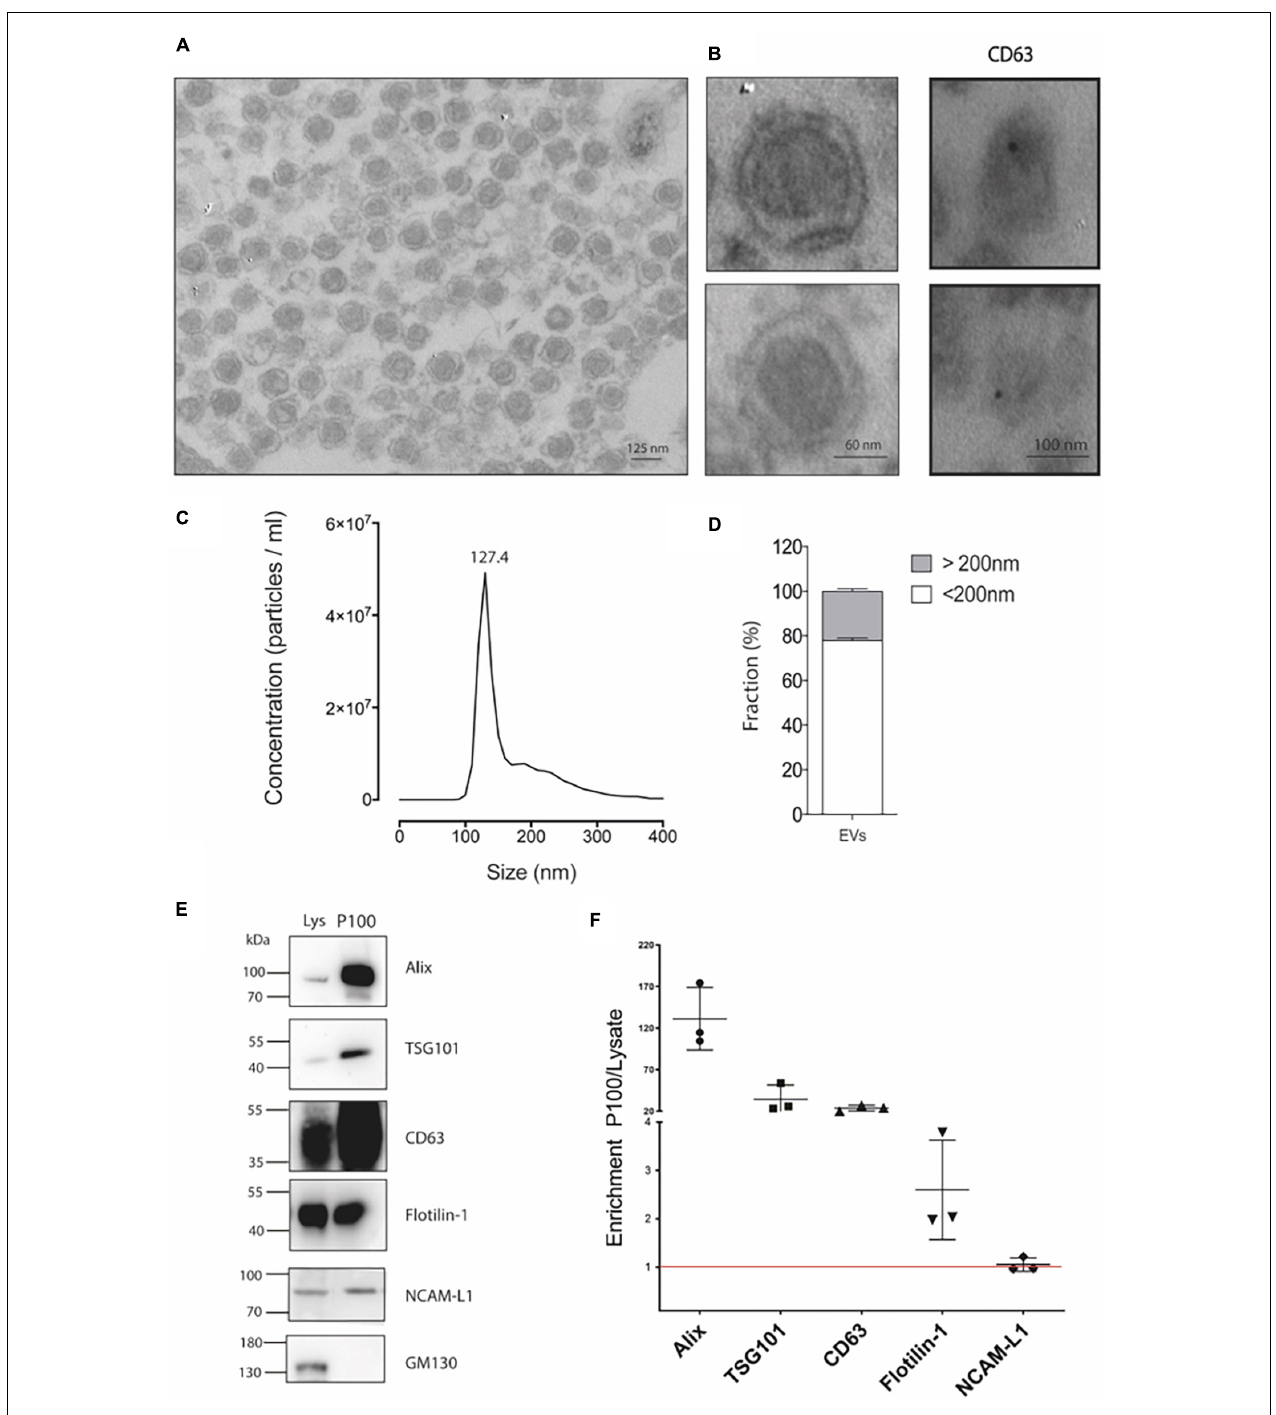
FIGURE 1 | Detailed characterization of P100 vesicles secreted from hippocampal HT-22 cells. (A) Representative transmission electron microscopy of P100 shows abundant vesicles with exosome-like appearance with an average diameter of 124.1 ± 6.8 nm of ( n = 31; three independent cell culture preparations). (B) Close capture of single exosomes (left) and immunogold labeling of a selective exosomal biomarker, CD63 (right panel, black dot). (C) Nanoparticle tracking analyses show a mean peak at 127.4 ± 1.3 nm ( n = 5; five independent cell culture preparations). (D) Abundance analysis shows that 77.88 ± 2.41% of the vesicles have a diameter of < 200 nm and a 22.12 ± 2.41% > 200 nm ( n = 4; four-five independent cell culture preparations). (E,F) Western blot and Analysis enrichment (fold) of the protein content of the exosomal markers Alix, 131.08 ± 37.7; TSG101, 34.36 ± 17.00; CD63, 23.82 ± 3.50; Flotillin-1, 2.60 ± 1.03; NCAM-L1, 1.05 ± 0.14. The control GM130, a Golgi-associated protein, was absent. Enrichment is relative to their levels in the lysate. The values were obtained from three independent cell culture preparations.